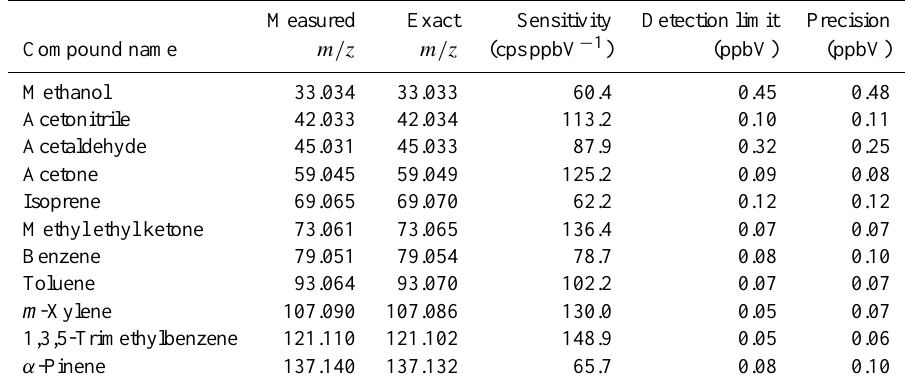
Table 1. 1Hz measurement performance results (measured accurate m/z , calculated exact m/z , instrumental sensitivity, 2 σ detection limit and precision at 1ppbV) for a set of 11